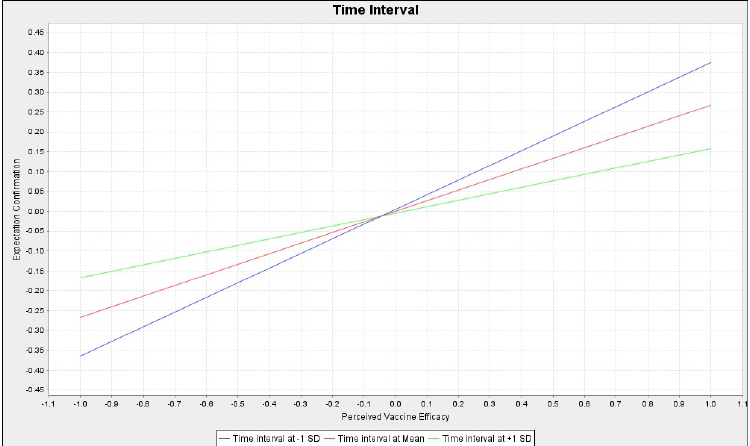
Figure 3. The moderating effects of the time interval: Simple slope analysis